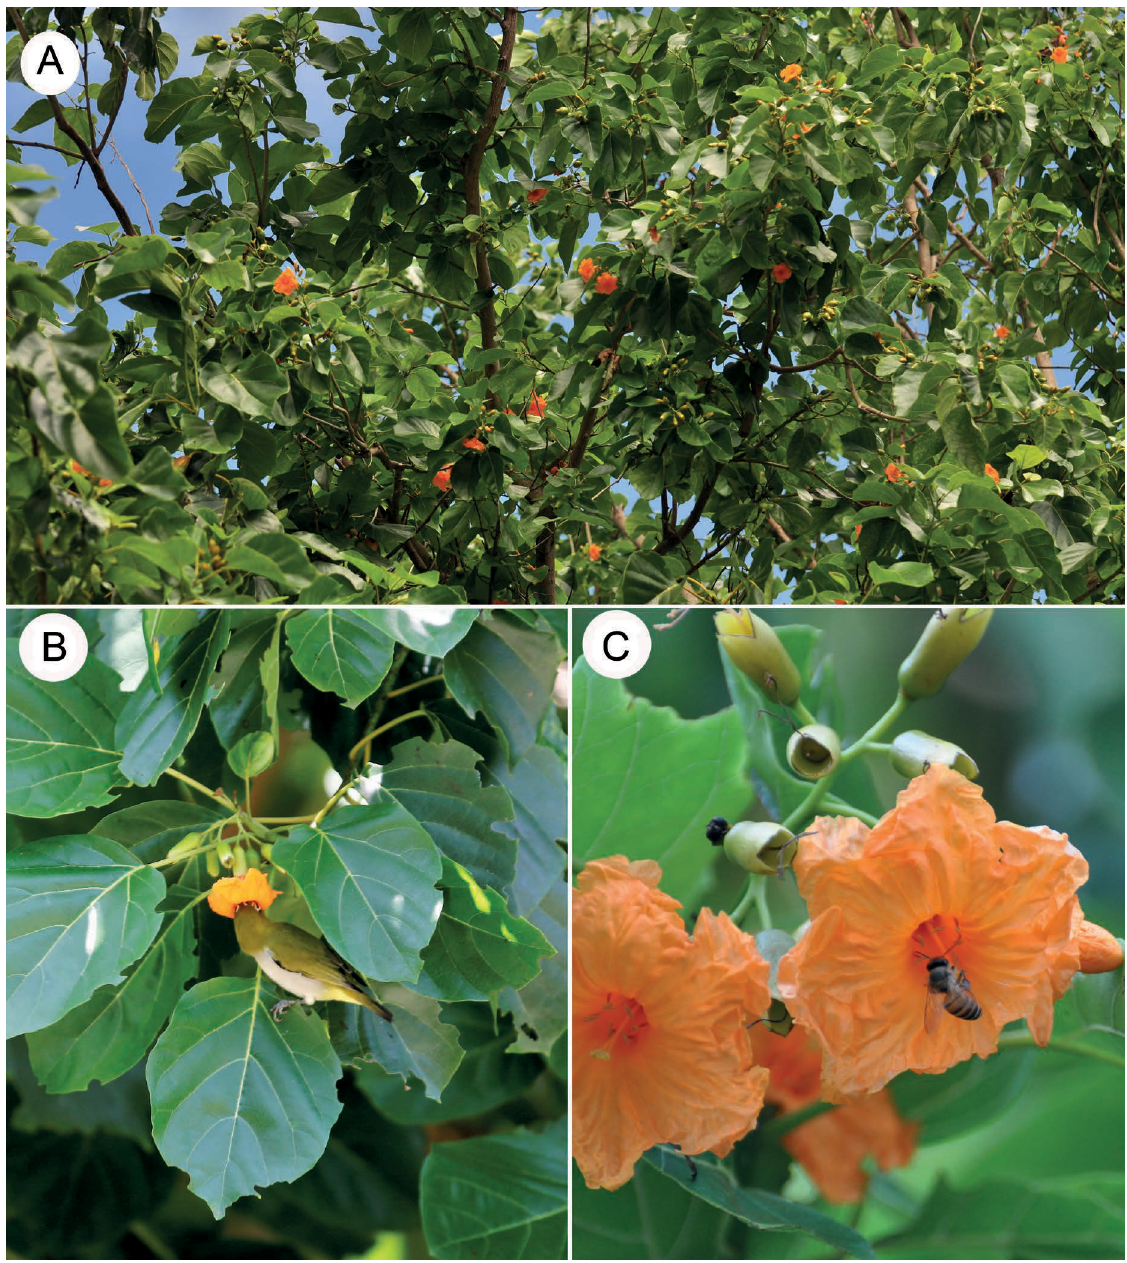
Figure 2 – Flowers and visitors of Cordia subcordata . A . Orange flowers in a tree on Yongxing Island (visitor observation area). B . Zosterops japonicus visiting flowers for nectar. C . Apis cerana visiting flowers for pollen. A photographed by Xiangping Wang; B & C photographed by Meihong